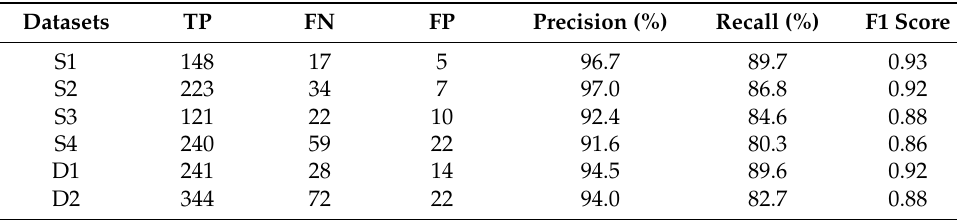
Table 3. Quantitative evaluation of reconstructed building